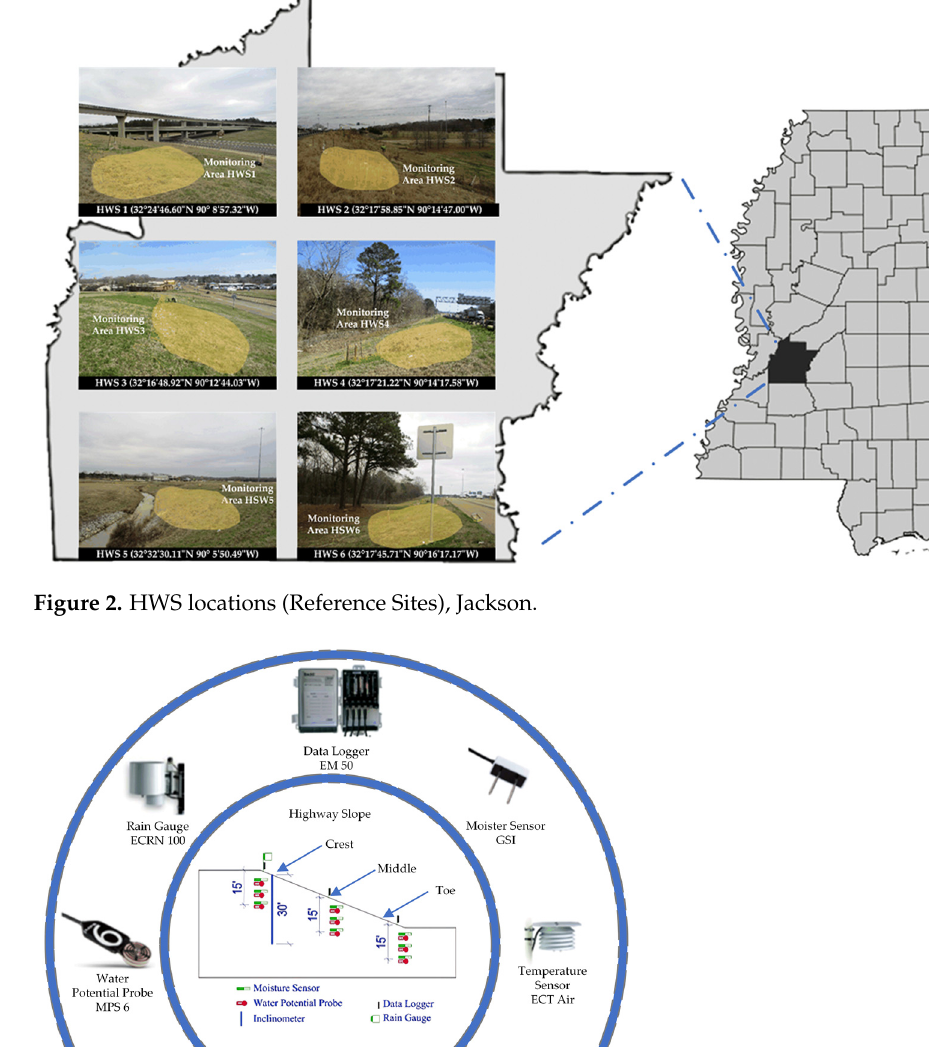
Figure 2. HWS locations (Reference Sites), Jackson.